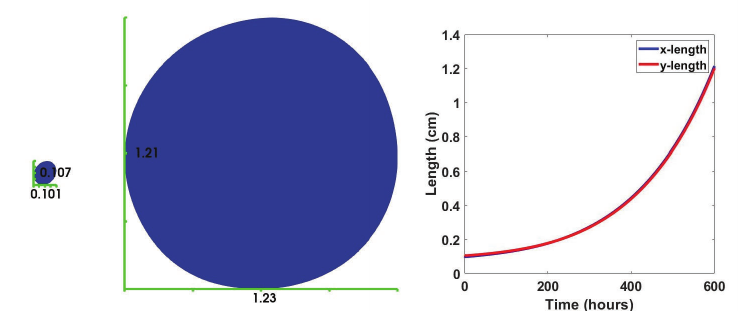
Figure 4. Comparison between the dimensions of the tumor at t = 0 h versus t = 600 h. The graphs show the time evolution of the bounding box dimensions.